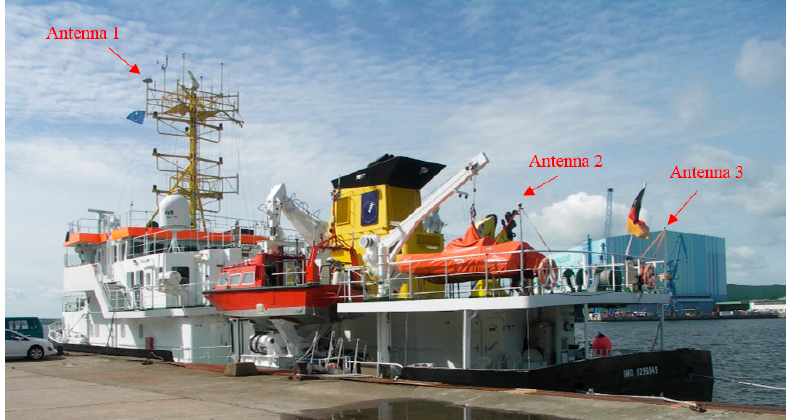
Figure 1. The ship used in the Baltic Sea gravimetric campaign and the positions of the three Global Navigation Satellite System (GNSS) receiving antennas.